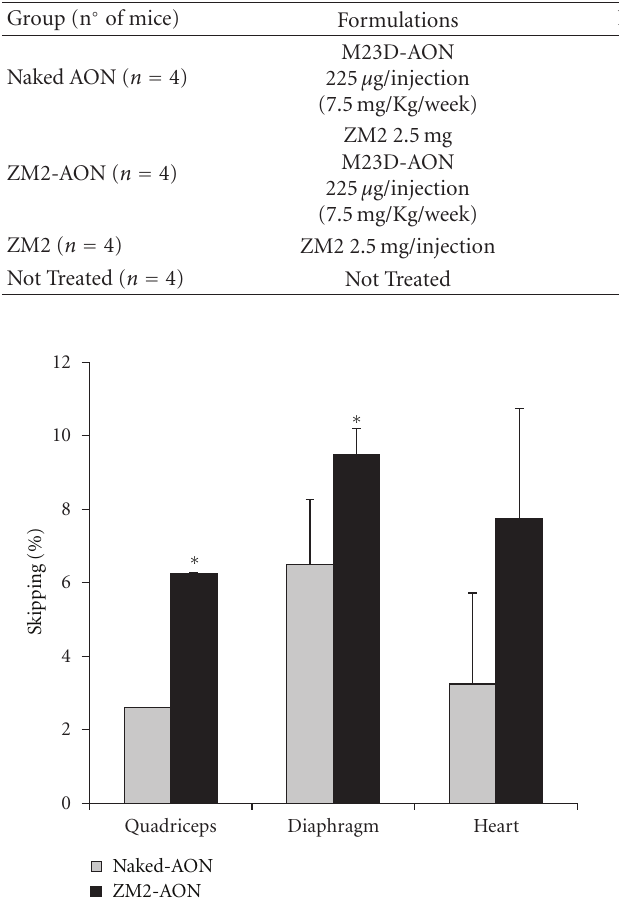
Figure 1: RT real time PCR exon-skipping quantification. His- tograms show the percentages of exon–23-skipped transcript, calibrated on exons 8 and 25 ( ΔΔ Ct method) and calculated in treated (ZM2-AON and naked AON) with respect to untreated mdx mice. The in-frame skipped product was detected in all skeletal muscles and the heart at percentages ranging from 6.3 to 9.5% in ZM2–AON-treated mice (black bars) and from 2.6 to 6.5% after treatment with naked AON (grey bars). Asterisks ( ∗ ) indicate statistical significance at P < 0 . 005. Error bars represent mean ±